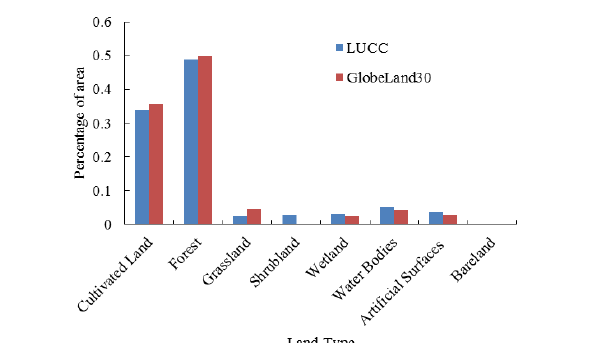
Figure 4. Comparison of GlobeLand30 and China land use data in northern Jiangxi Province